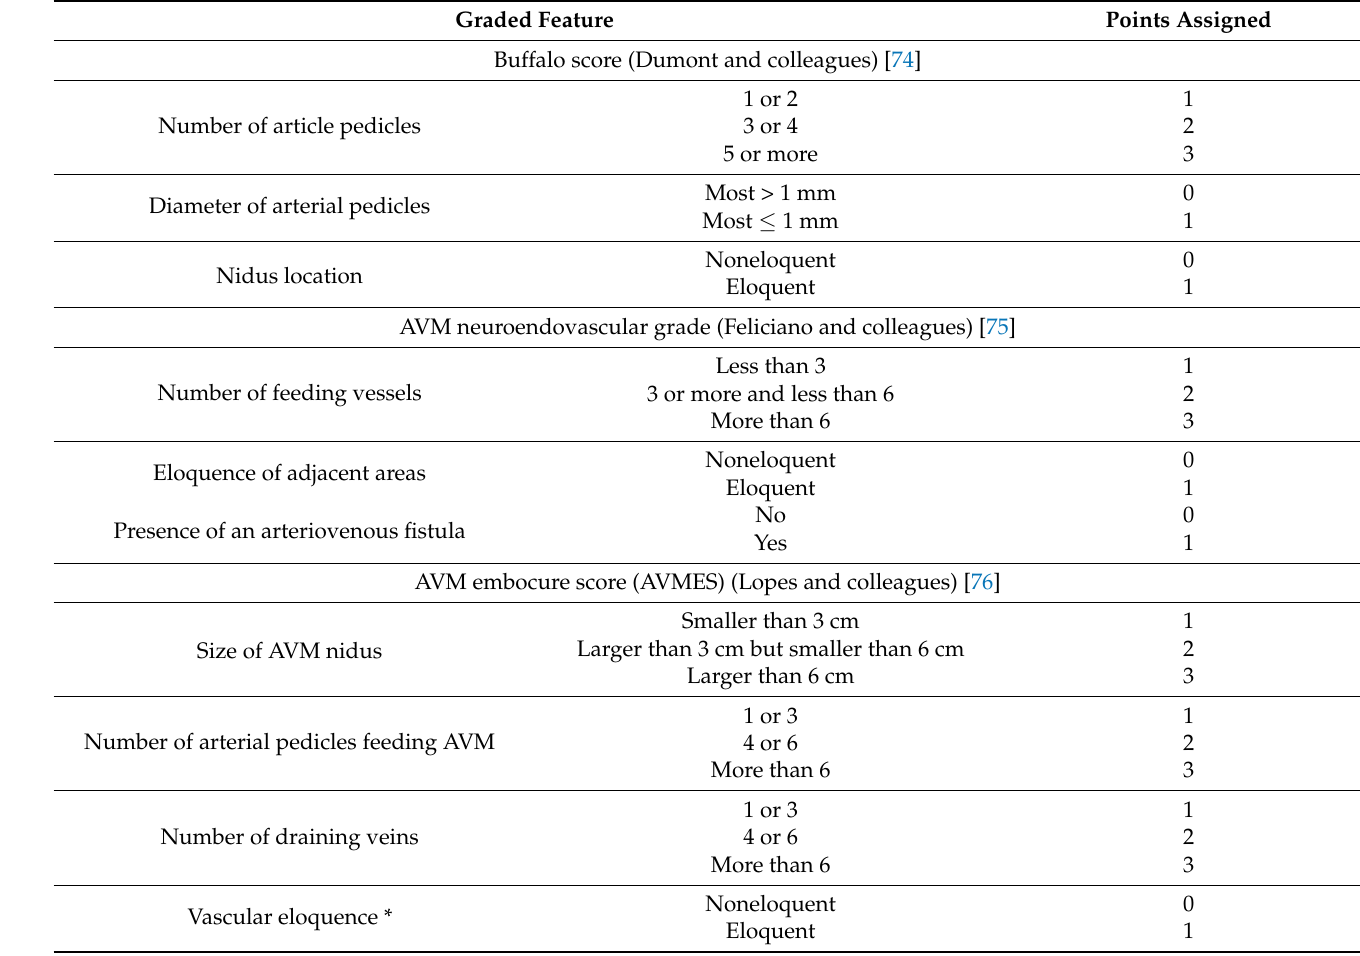
Table 1. The proposed grading scales for endovascular embolization and their